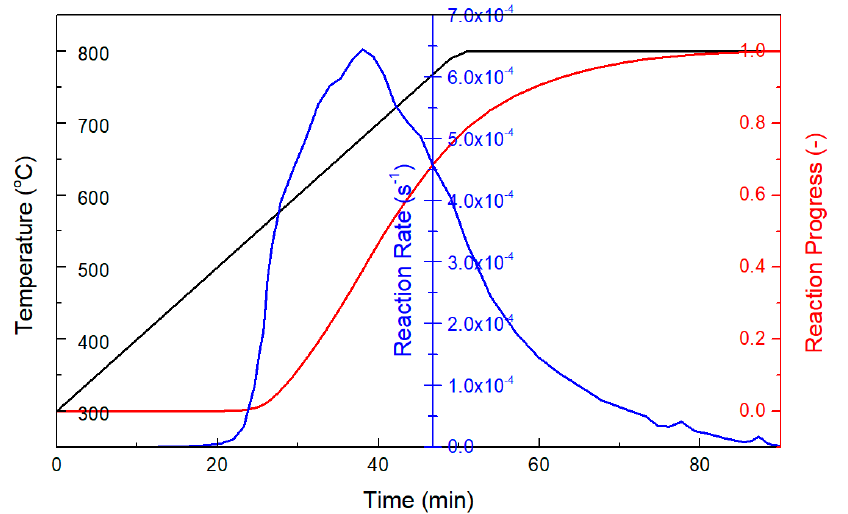
Figure 6. Optimized carbonization reactor heating condition for the completion of carbonization reaction step (R3) with a slow ramping rate to 800 °C to avoid the sudden generation of a large amount of UHCs.